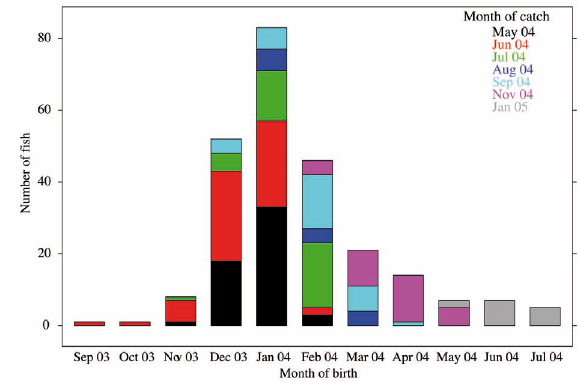
Fig. 5. – Monthly frequency distribution of birthdates of sardine juveniles. Each bar shows the proportion of individuals originating from each sampling